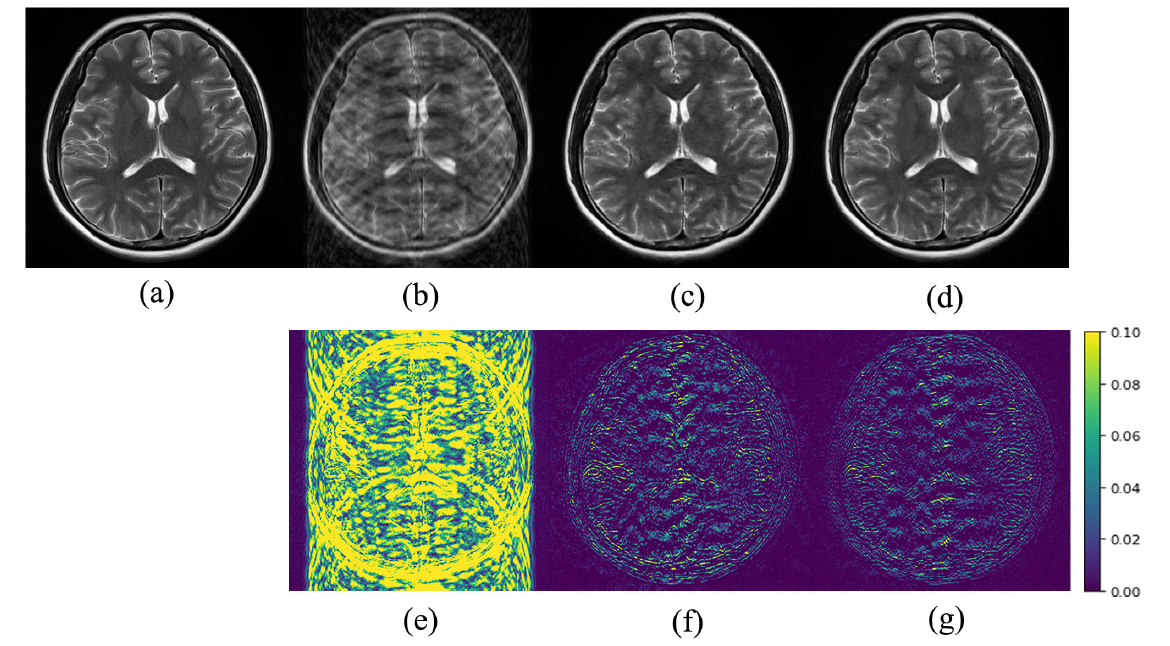
Figure 6. Comparison of the reconstruction results of the target MR image: ( a ) in Brain B using the Cartesian undersampled mask with 30% sampling rate; ( b ) zero-filling reconstruction; ( c ) DIP reconstruction; ( d ) the proposed method reconstruction and corresponding error maps ( e )–( g